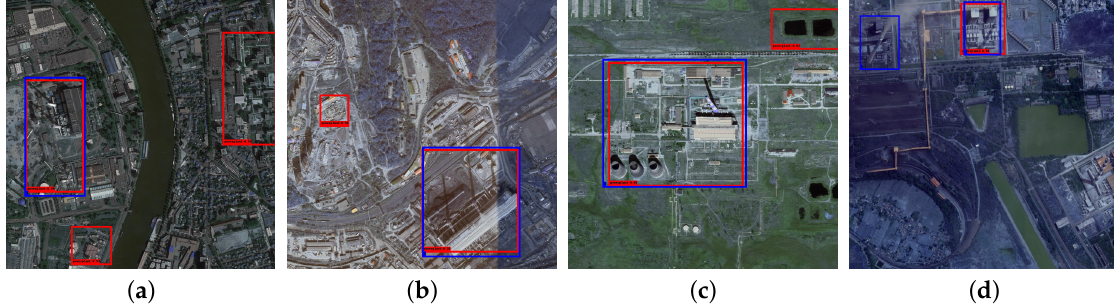
Figure 9. False alarms and missed alarms on hard examples. ( a ) Disturbances: buildings; ( b ) Disturbances: parking lots; ( c ) Disturbances: pools that locate near a TPP but do not belong to it; ( d ) Missed alarms caused by occlusion and edge